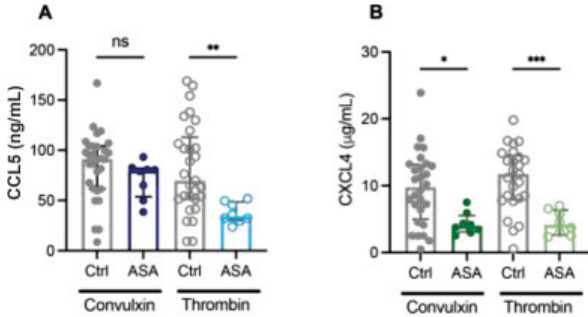
Fig. 3 Effect of acetylsalicylic acid (ASA) on chemokine release. Washed platelets (2 (cid:1) 10 8 /mL) from healthy volunteers exposed to ASA (100mg p.o.) were activated and CCL5 ( A ) and CXCL4 ( B ) release was determined as described. Closed circles represent convulxin activation and open circles represent thrombin activation. CTRL: n ¼ 25 – 30; and ASA: n ¼ 8. Median with interquartile range. (cid:4) p < 0.05; (cid:4)(cid:4) p < 0.01; (cid:4)(cid:4)(cid:4) p < 0.001; Kruskal-Wallis with Dunn ’ s test.